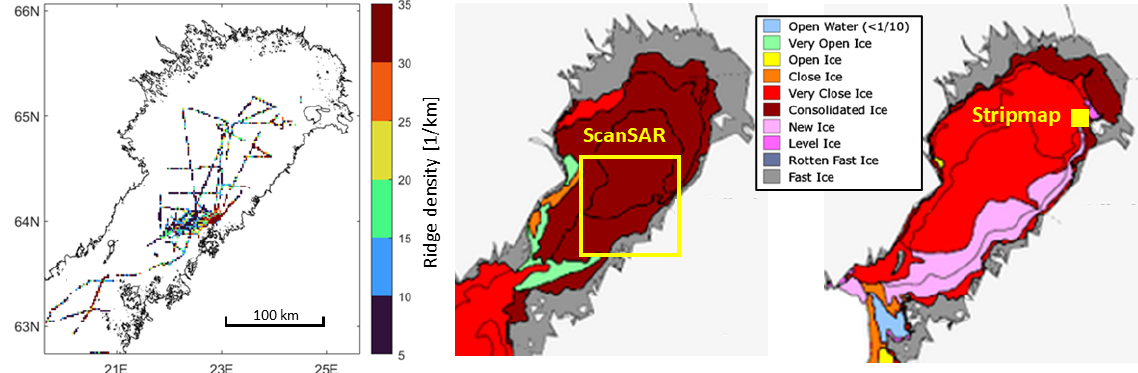
Figure 1. The profiling measurement lines during the 2011 field campaign. The ice conditions on the days of the